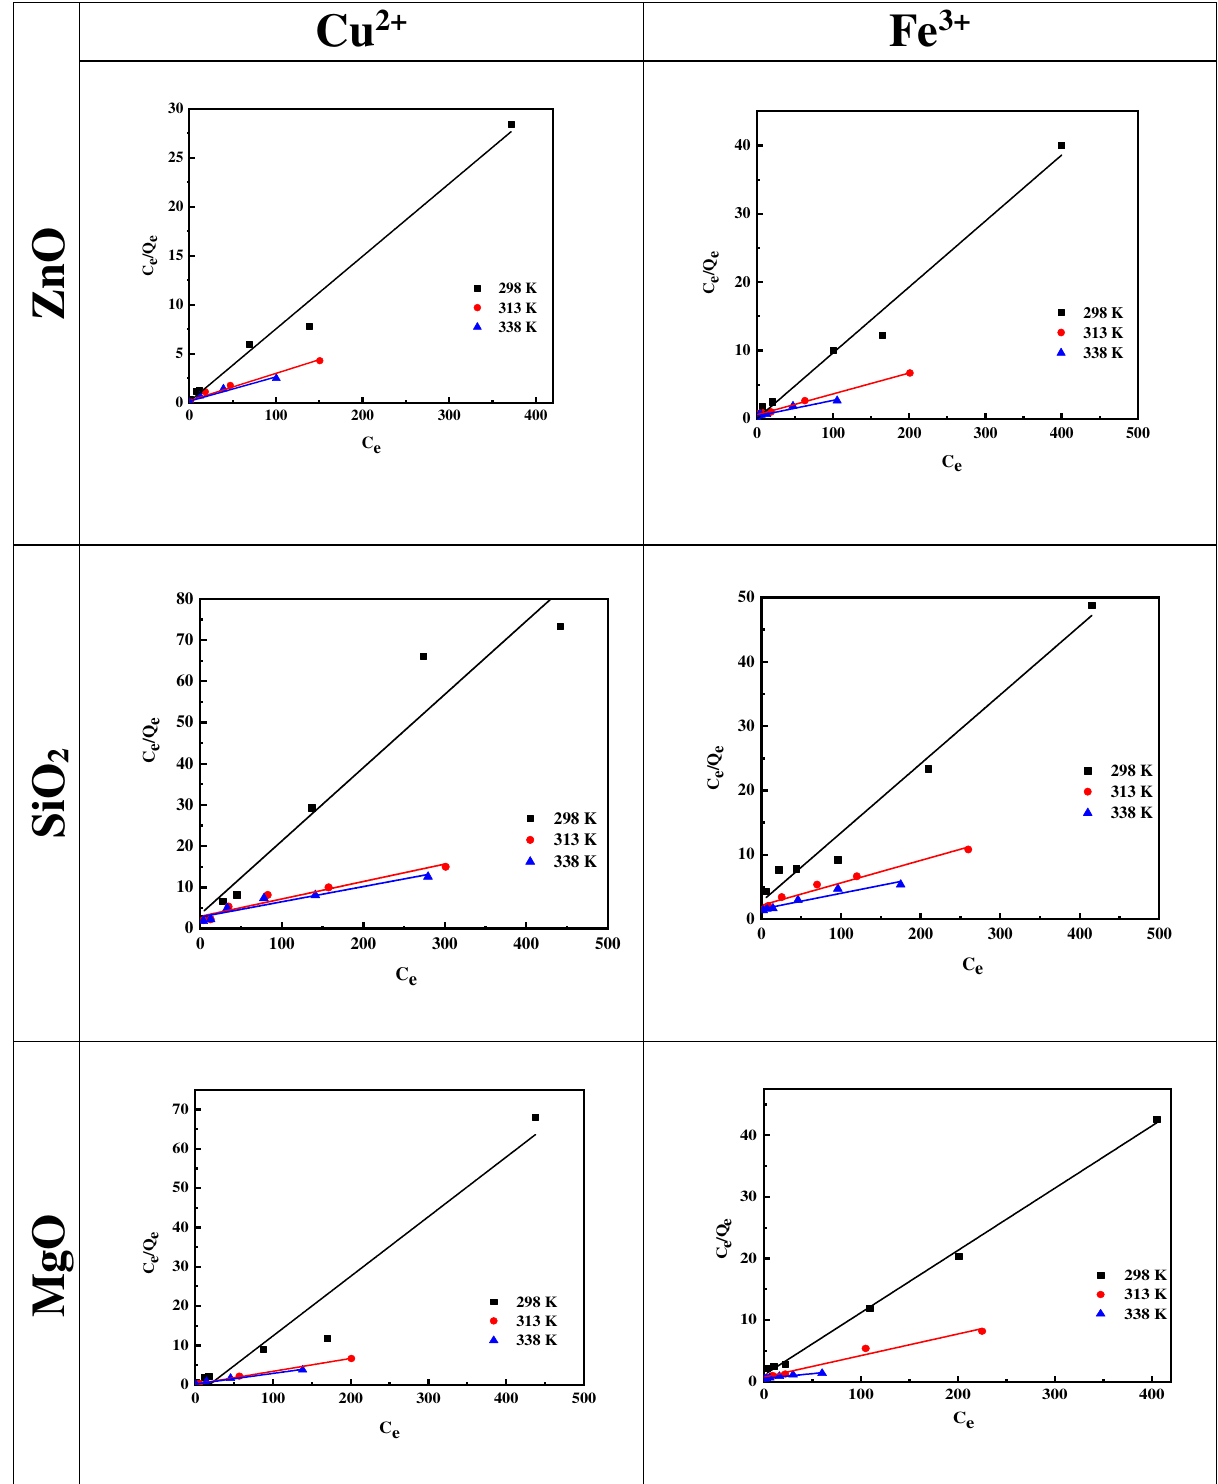
Figure 7. Linearized Langmuir isotherms for Cu and Fe ions adsorption on ZnO, MgO, and SiO 2 NPs at different